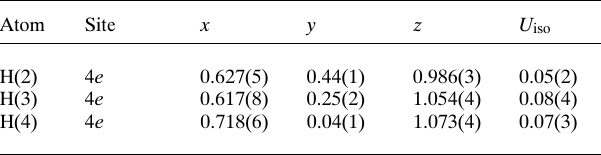
Table 2. Atomic coordinates and displacement parameters (in Å 2 ) .